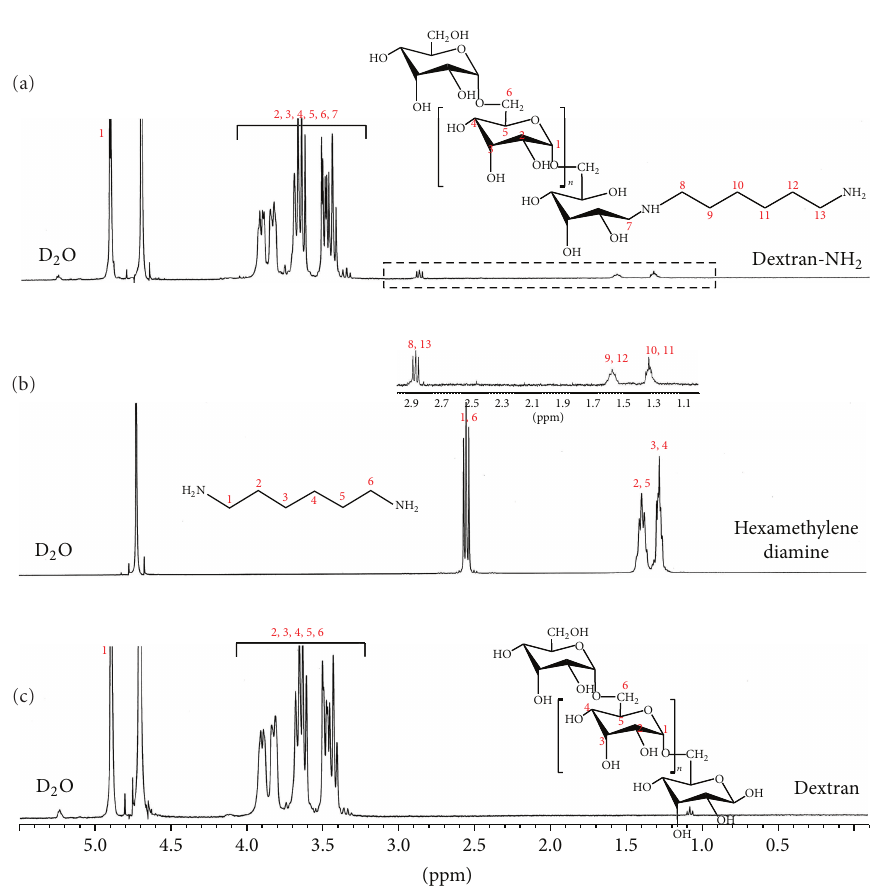
Figure 2: 1 H spectra of dextran (a), hexamethylene diamine (b), and dextran-NH 2 (c) in D 2 O.